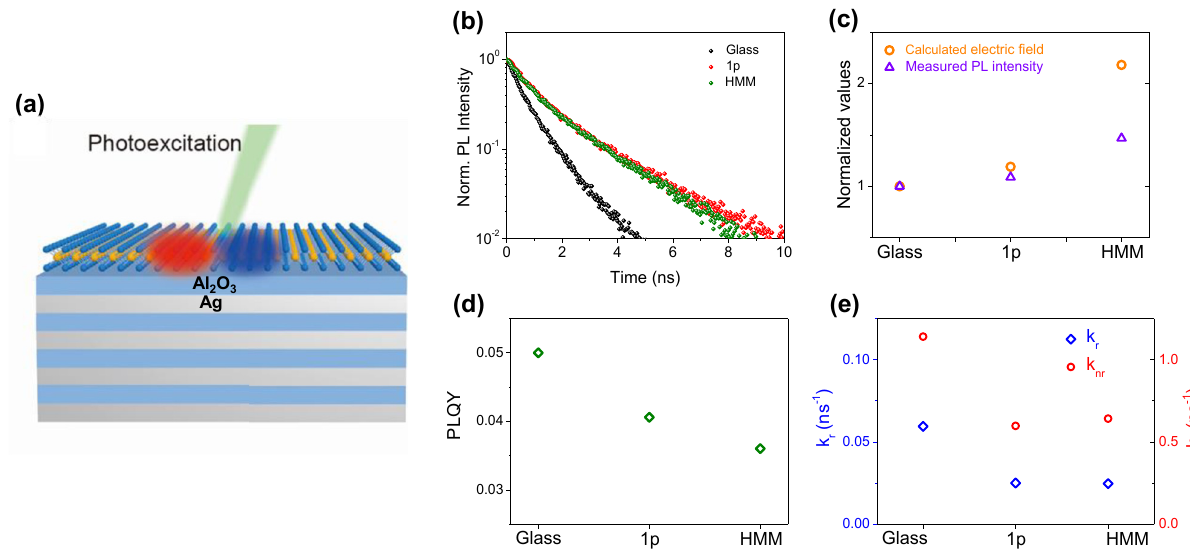
Figure 3: Change in photophysical properties due to 2D nature of WSe monolayer. (a) Schematic illustration of experimental configuration exhibiting 2 monolayer on metamaterial substrate consisting of Ag and Al O alternative layers. Blue and red colors represent electron and hole a WSe 2 2 3 monolayers on glass (black), 1p (red), and HMM (green) wavefunctions, respectively. (b) Measured time-resolved photoluminescence of WSe 2 monolayers (purple) on glass, 1p, and HMM substrates. (c) Plots of calculated electric-field intensity (orange) and measured PL intensity of WSe 2 substrates. The electric field intensity and PL intensity are normalized by the corresponding values of the glass substrate. (d) Estimation of monolayers on glass, 1p, and HMM substrates. (e) k and k values for glass, 1p, and, HMM photoluminescence quantum yield WSe 2 r nr